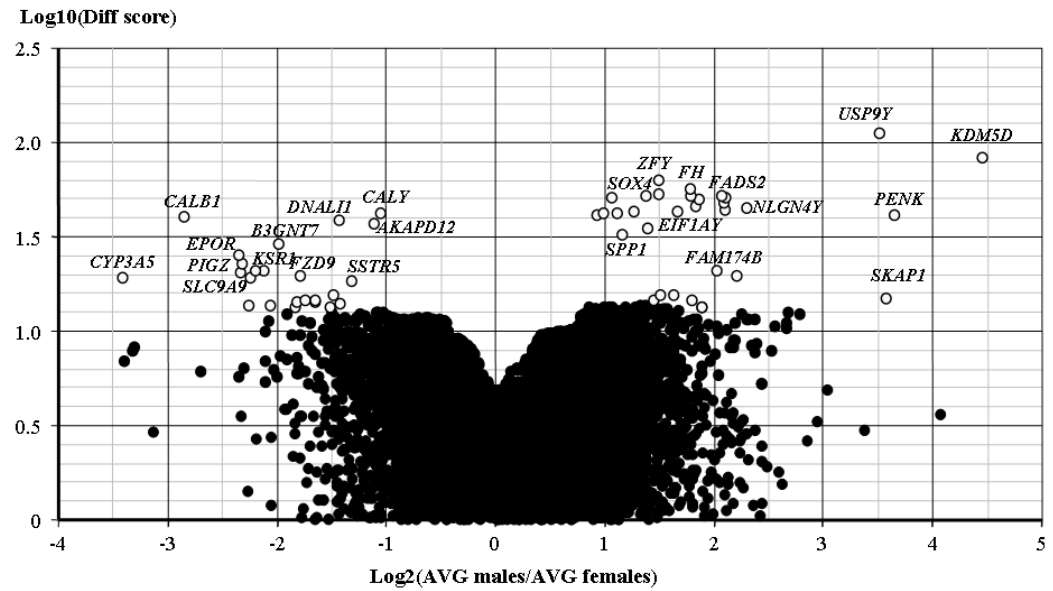
Figure 1. Volcano plot. Genes up- and down-regulated specimens from male vs. female patients. Effect (ratio of average signal, AVG) is shown on the x-axis and significance (Diff Score) on the y-axis. Up-regulated genes appear to the right and down-regulated genes appear to the left on the x-axis. White circles indicate significant genes (Diff Score > 13) and selected genes are identified by name. Table 4. Genes differentially regulated according to sex.